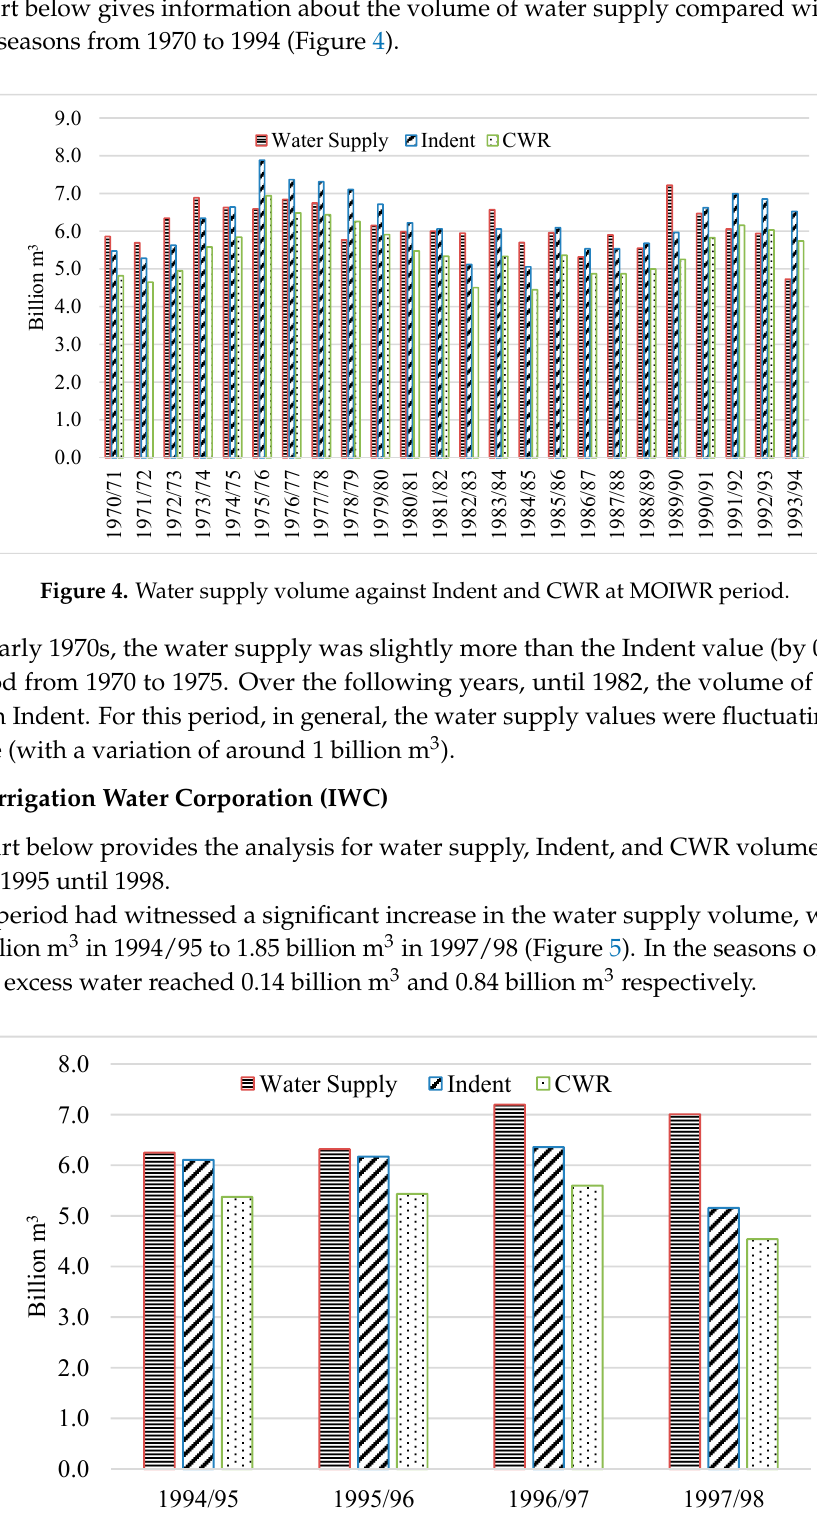
Figure 5. Water supply volume against Indent and CWR at IWC period.